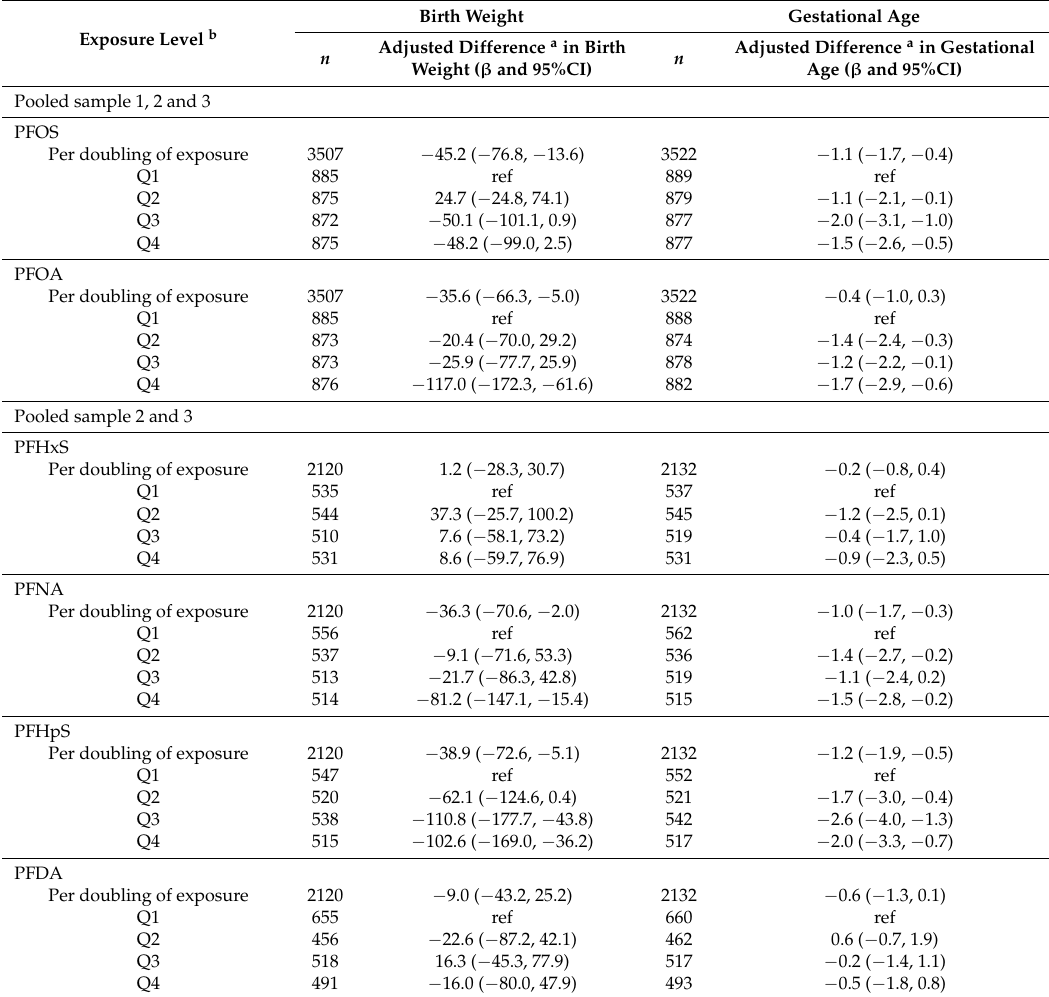
Table 2. Adjusted differences ( β ) and 95% confidence intervals (CI) for birth weight in grams and gestational age in days according to prenatal PFASs exposure levels. Birth Weight Gestational Age Exposure Level b Adjusted Difference a in Gestational Adjusted Difference a in Birth n n Age ( β and 95%CI) Weight ( β and 95%CI) Pooled sample 1, 2 and 3 PFOS Per doubling of exposure